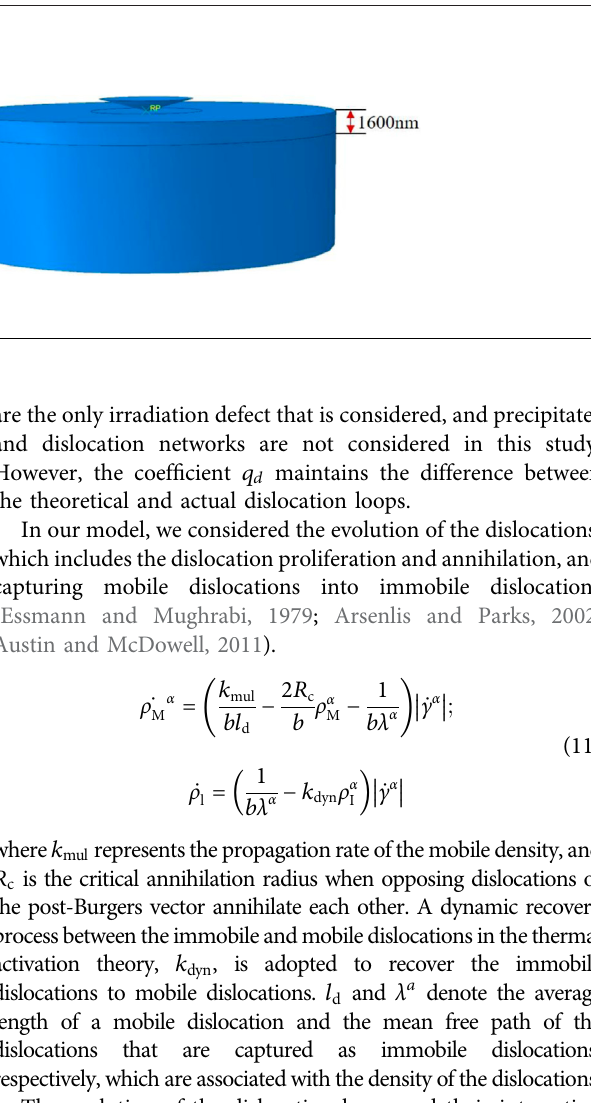
Frontiers in Materials |